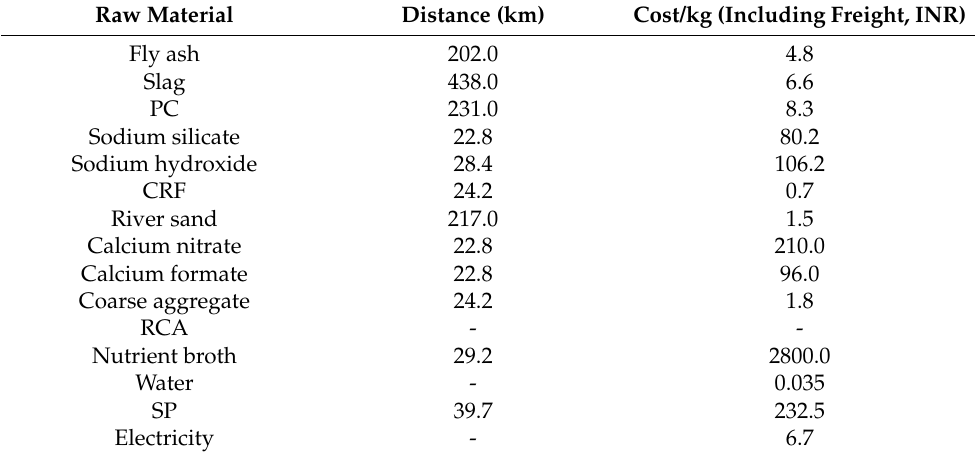
Table 5. Freight distances and unit cost of raw materials and